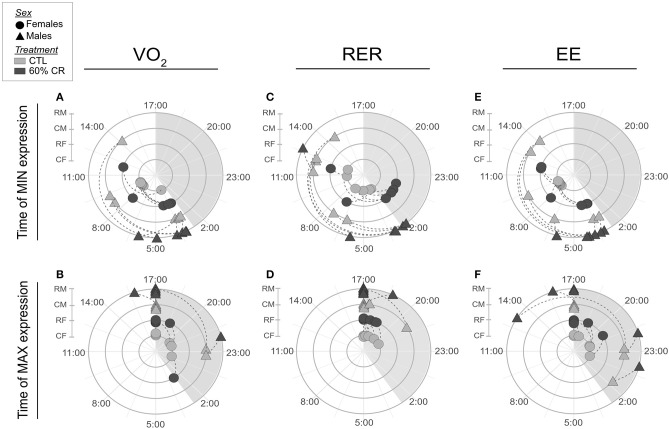
Polar graphics representing averaged time (in hh:mm) when minimum and maximum VO2 (A,B, respectively), RER (C,D), and EE (E,F) were expressed over a 24 h period. Female mouse lemurs are shown as circles, and male as triangles. CTL animals are in ligth gray, CR in dark gray. Each experimental group is represented on its own concentric circle: RM (CR males), CM (CTL males), RF (CR females) and CF (CTL females). Time shift is represented by a dashed line for each individual. The shaded phase between 17:00 and 3:00 is the dark phase of the day, when the lights are off.